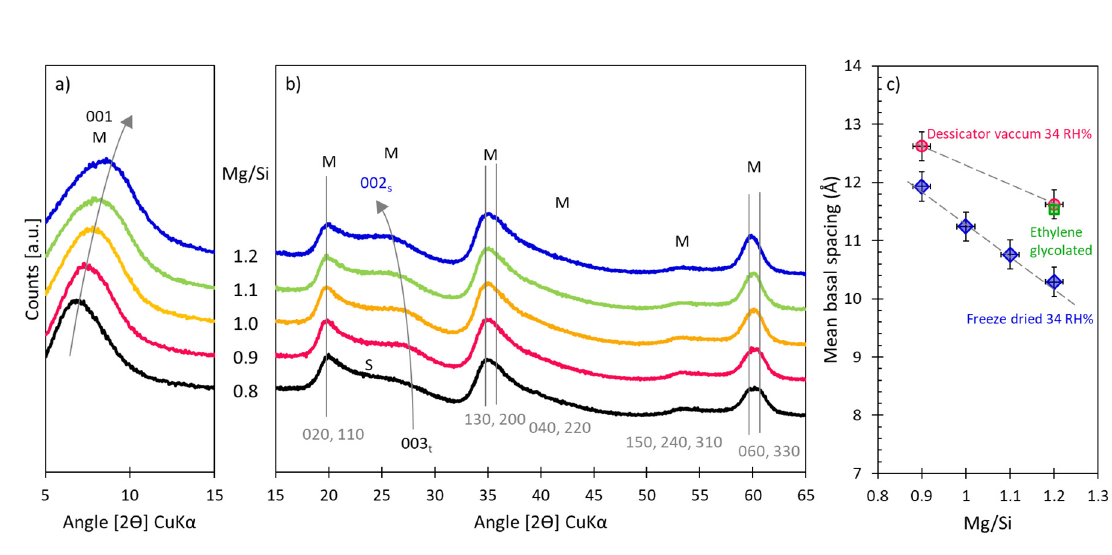
Figure 1 . a) and b) XRD patterns (indexed following the crystal structure of talc (=t), serpentine (=s) and Mg ‐ swelling clays (=M)), c) Mean basal spacing (layer ‐ to ‐ layer distance) measured from XRD patterns as a function of Mg/Si in M ‐ S ‐ H. Freeze dried=freeze dried samples and re ‐ equilibrated to 34RH% over CaCl 2 , desiccator vacuum=directly dried over CaCl 2 34RH% in a vacuumed